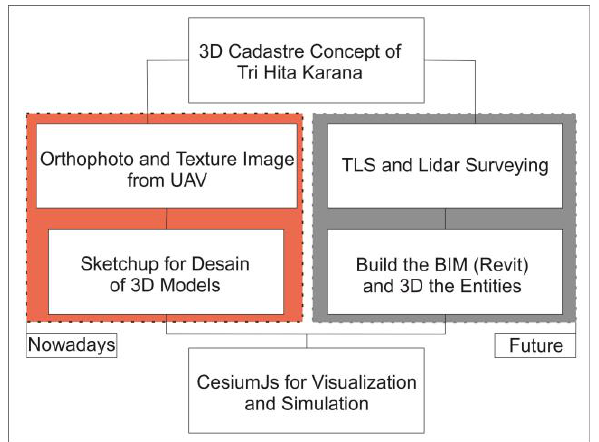
Figure 3. The methodology using Photogrammetry and BIM in 3D Cadastre.